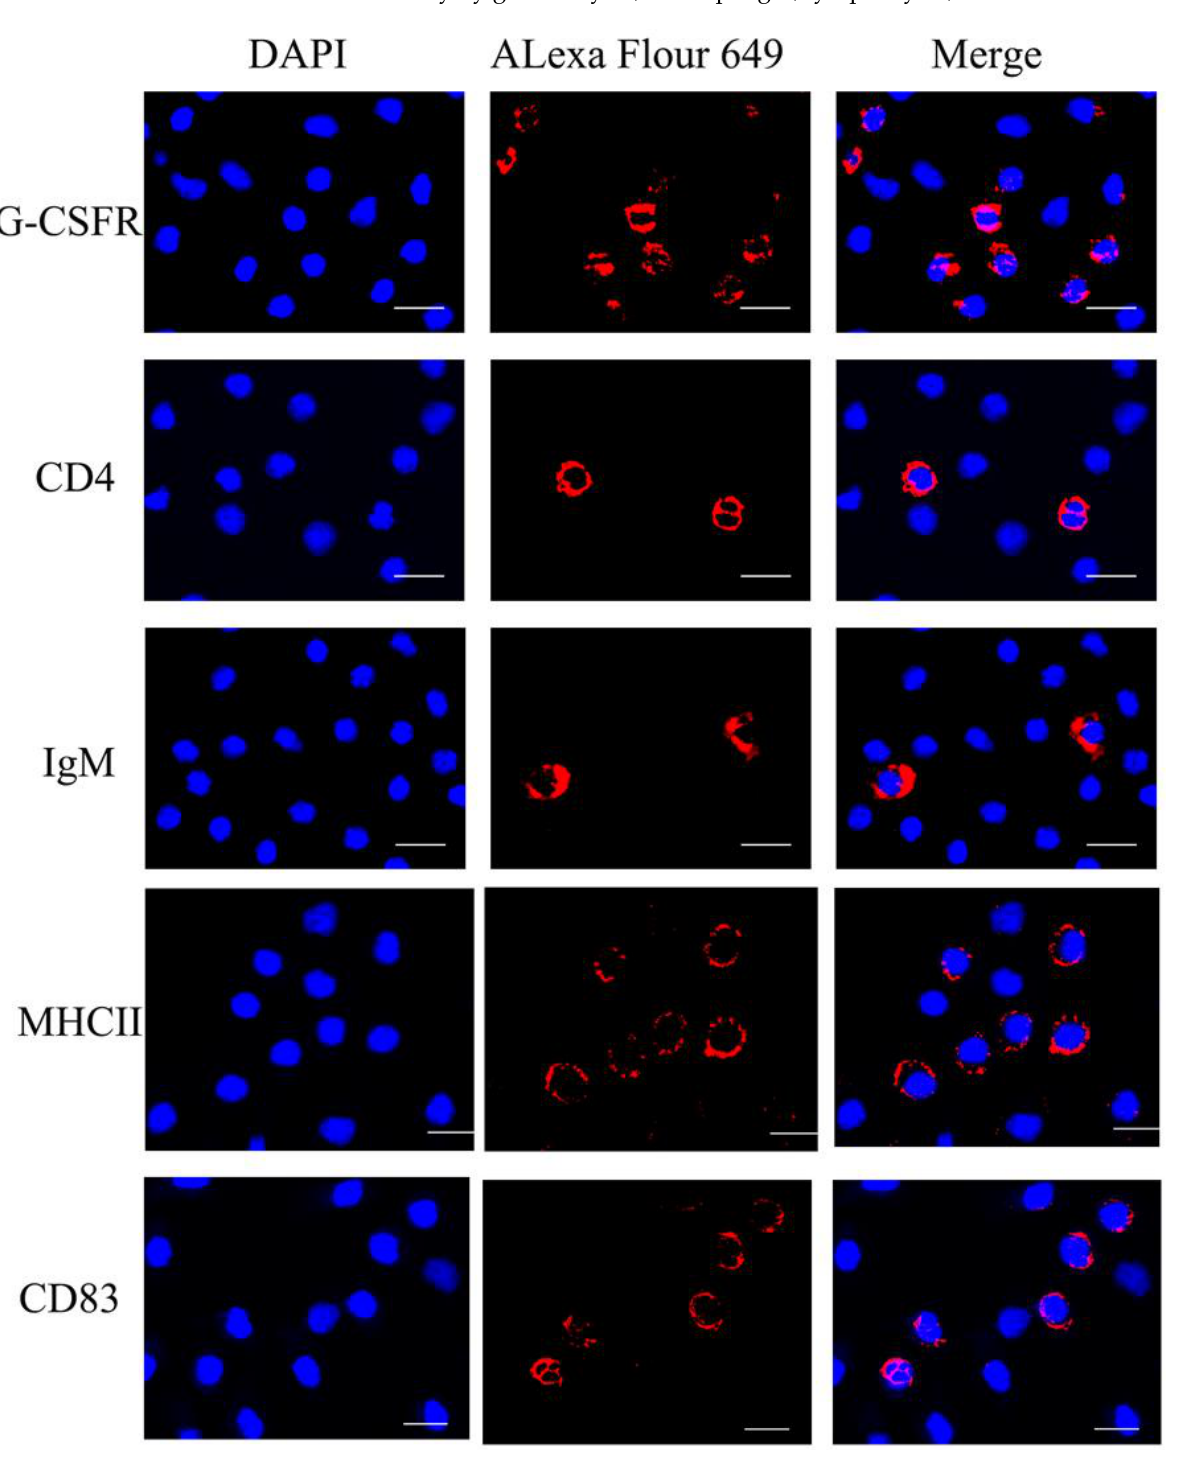
Figure 3. Immunofluorescence staining results for G-CSFR + , IgM + , CD4 + , MHCII + , and CD83 + cells among PerC cells. The red color shows that Alexa Flour 649 labeled antibodies and linked with the cell marker proteins. The nuclei were counterstained in blue with DAPI. Bar of both panels: 10 μm .